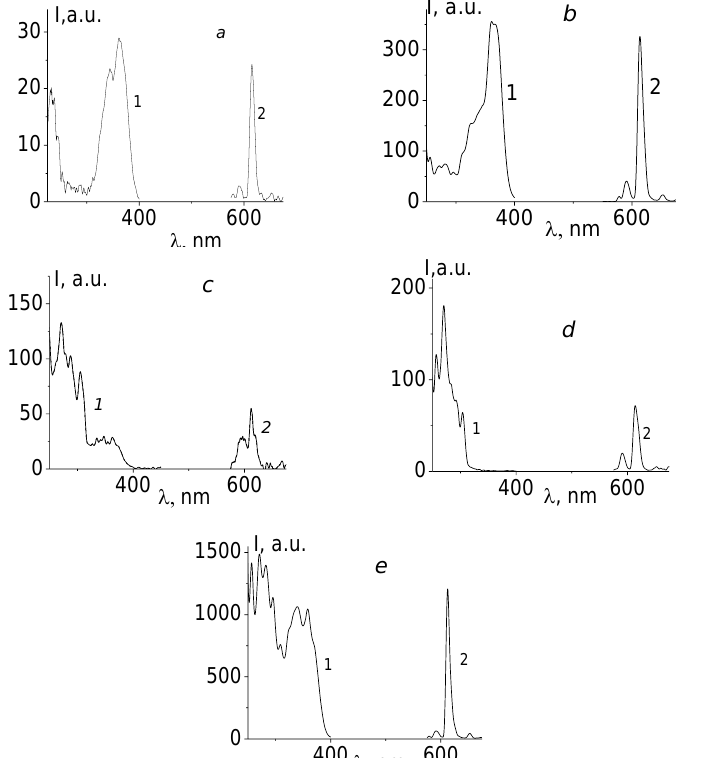
Figure 10. Excitation (1) and photoluminescence (2) spectra of solutions of Eu 3+ /TTA ( a ), Eu 3+ /4-AM-VPA/TTA ( b ), Eu 3+ /PHEN ( c ), Eu 3+ /4-AM-VPA/PHEN ( d ), and Eu 3+ /4-AM-VPA/TTA/PHEN ( e ).